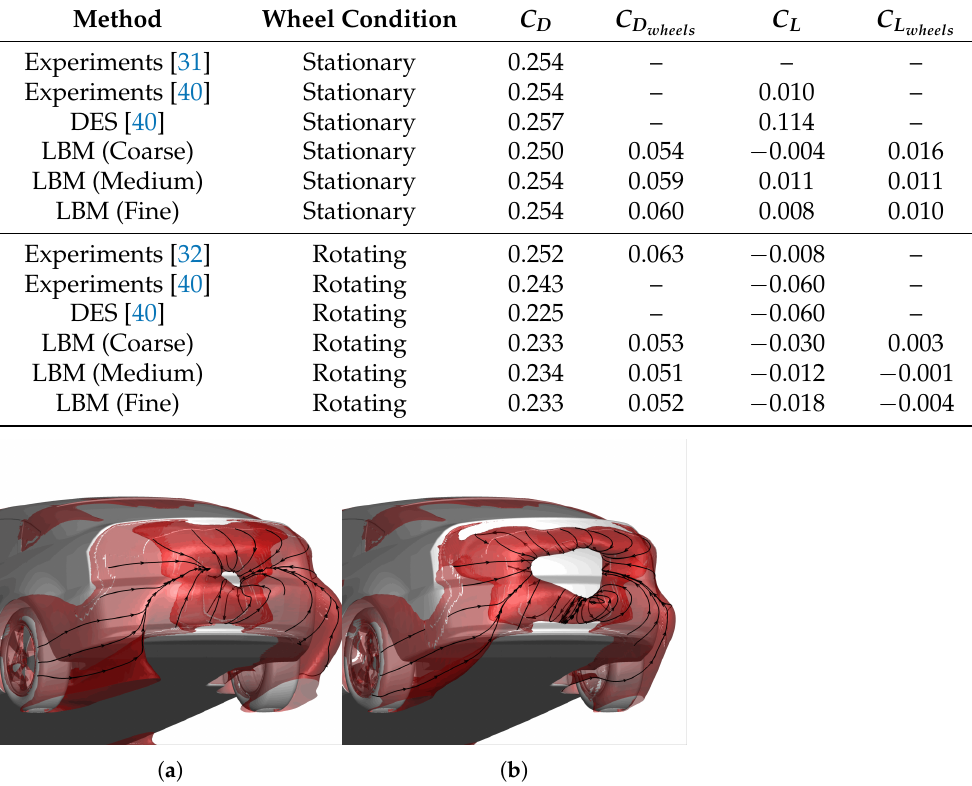
Figure 4. Iso-surface of the time-averaged total pressure coefficient C p 0 = − 0.025 overlayed with streamlines for the ( a ) stationary wheels and ( b ) rotating wheels